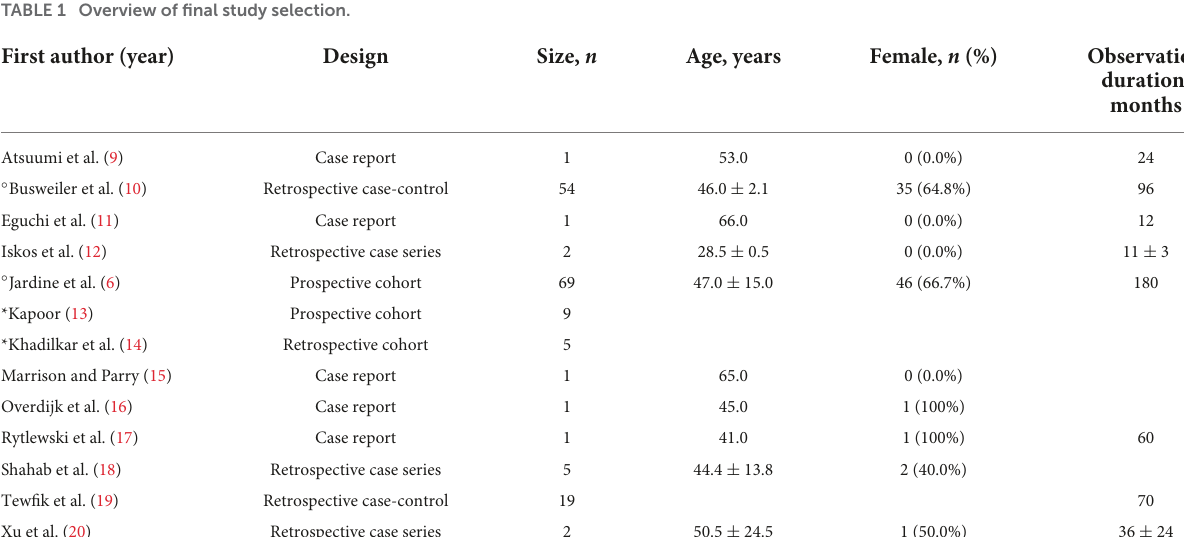
TABLE 1 Overview of final study